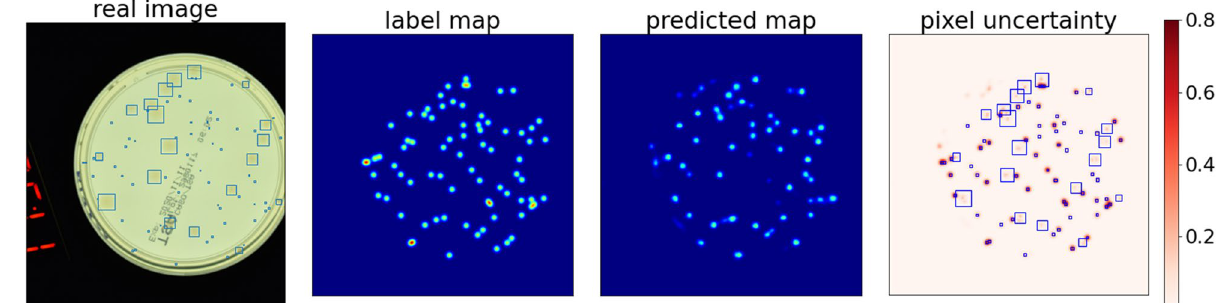
Figure 10. Density maps of one of the outliers from Fig. 4 predicted with the SNDM. The model predicts 29 ± 7.30 colonies, while the sample contains 77 colonies of two types: 19 P. aeruginosa (big ones), and 58 C. albicans (small ones). The blue boxes represent all the colonies’ ground truth position and size. Uncertainties calculated using the bootstrap